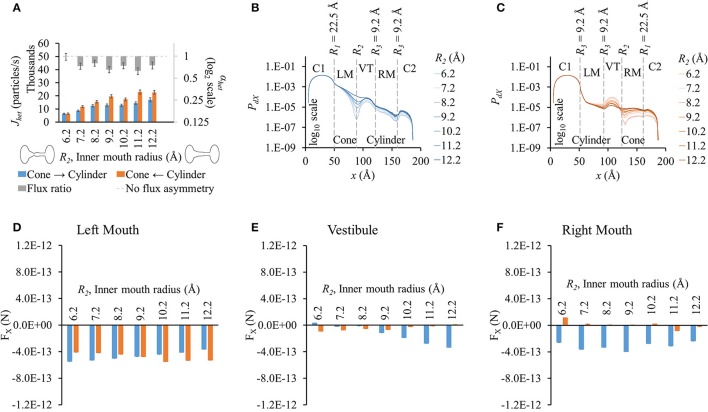
Properties of heterotypic pores with varying inner mouth size of conical section (22.5-R2-9.2-9.2). (A) LY fluxes rose in both directions with increasing inner mouth size (only R2). Differences between Jhet,1 and Jhet,2 vary amongst the different cases. LY flux ratio variations appeared to be multimodal with increasing R2 with maximum flux asymmetry at R2 = 9.2 Å and 11.2 Å. (B)
PdX in cone to cylinder direction dropped near R2 and maintained almost a uniform difference amongst the different inner pore mouth sizes. (C)
PdX in the cylinder to cone direction decreased in the left mouth and vestibule with increasing R2. This tendency flipped by the end of the vestibule with PdX levels increased with increase in R2 in the right mouth. (D–F) Average force per LY particle in (D) left mouth, (E) vestibule, and (F) right mouth. (D) Increase in R2 caused FX magnitudes (-x direction) in the left mouth to gently decrease in the cone to cylinder direction, and gently rise in the cylinder to cone direction. (E) In the vestibule, FX increased in the cone to cylinder direction, while decreased in the cylinder to cone direction with increase in R2. (F) FX magnitudes in the cone to cylinder direction were negative and varied randomly in the right mouth.